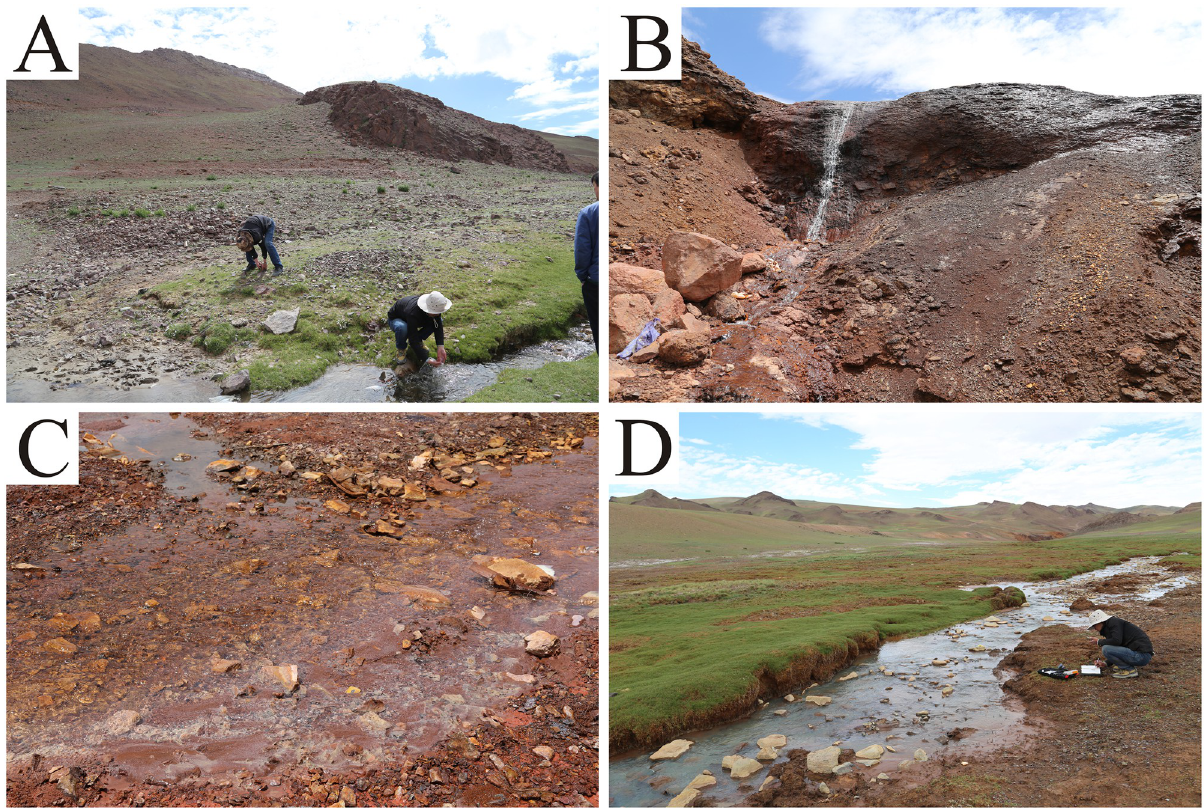
Fig 1. Photographs of the Rongna River. Panel A represents the uncontaminated upstream section of the Rongna River; panel B represents the AMD from the deposit; panel C represents the river section after the AMD flows into it; and panel D represents the river section far away from the deposit